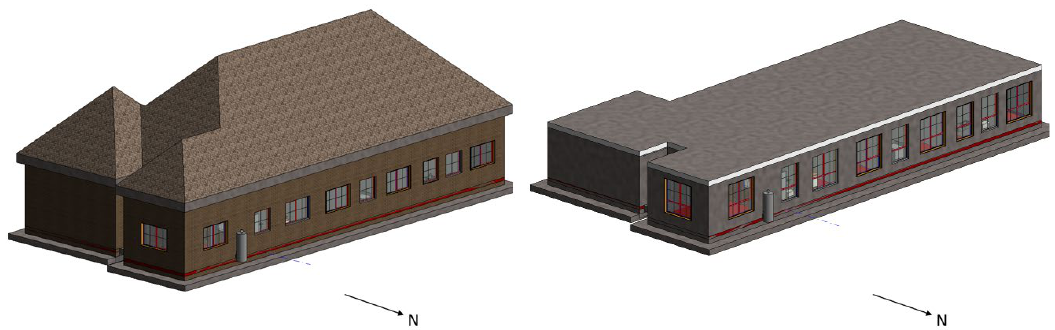
Figure 3. Development of building models (conventional and precast) in Autodesk Revit (BIM).